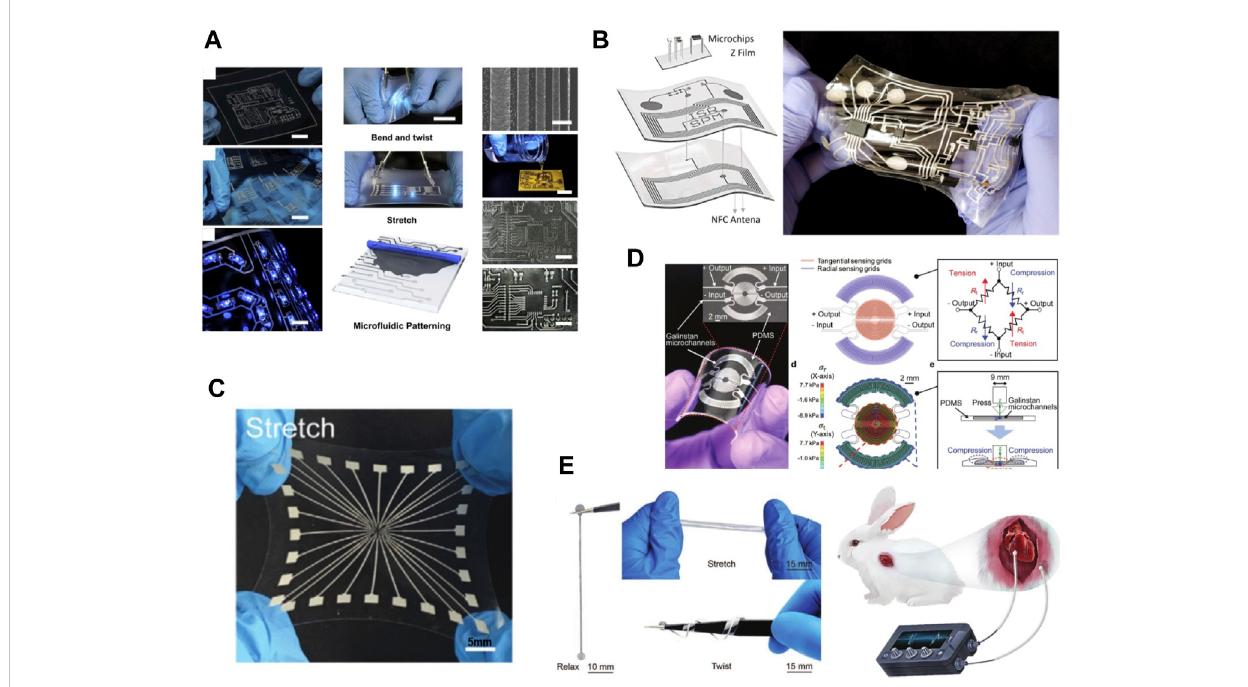
FIGURE 1 Applications of liquid metals in soft electronics. (A) Printing for making stretchable conductor (TANG et al., 2018) (B) Printing liquid metal to realize multi-layer circuit(LOPES etal., 2021a) (C) Highly stretchable liquid metal electrodearray for Electrophysiology (DONG etal., 2021a). (D) Pressure sensor made of liquid metal (GAO et al., 2017) (E) Soft pacemaker made of liquid metal (HANG et al.,